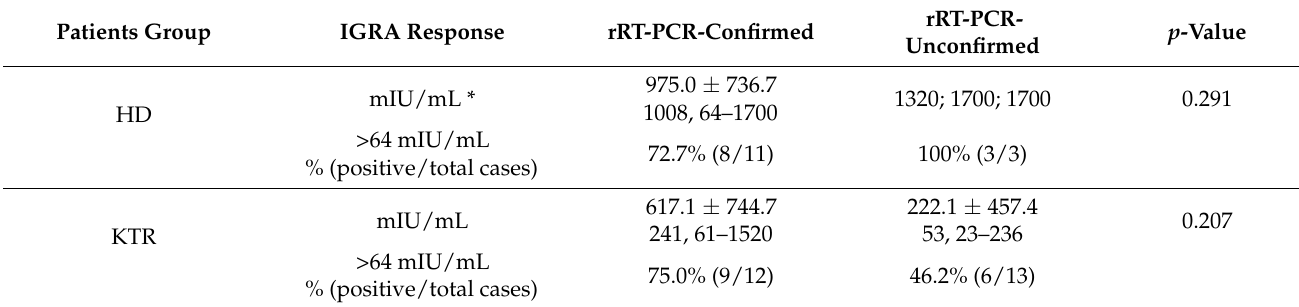
Table 4. Anti-SARS-CoV-2 cellular response in relation to the history of rRT-PCR-confirmed or unconfirmed SARS-CoV-2 infection in convalescent hemodialysis and kidney transplant patients. Patients